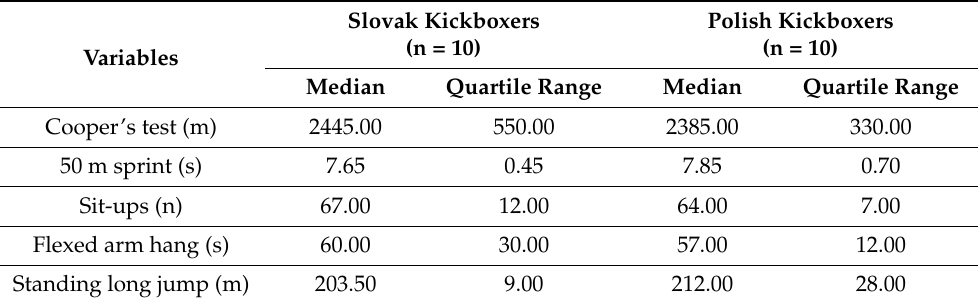
Table 2. Physical